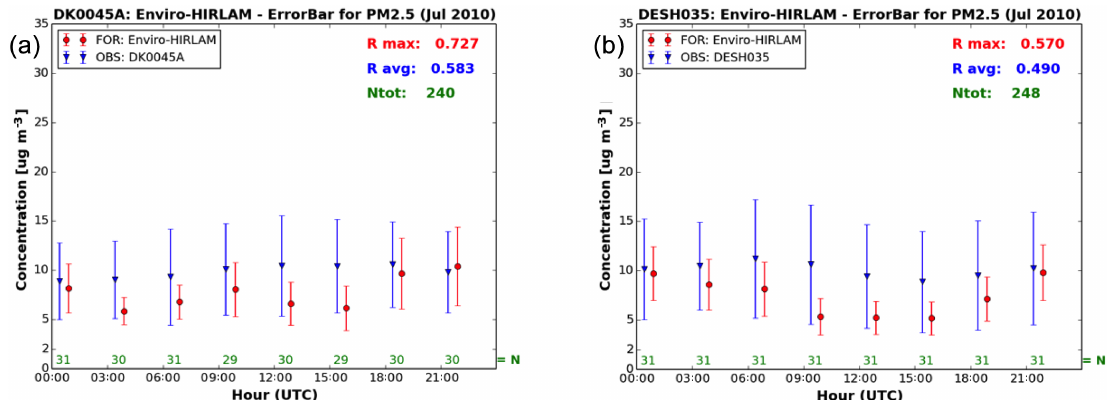
Figure 15. Error-bar concentrations (µgm − 3 ?) on the diurnal cycle for AirBase observations versus Enviro-HIRLAM modelling results: (a) Danish urban station and (b) German rural station. The top right corner indicates maximum and average correlation coefficients for the station as well as total number of analysed observation samples. Green numbers along the x axis indicate number of observation samples per time